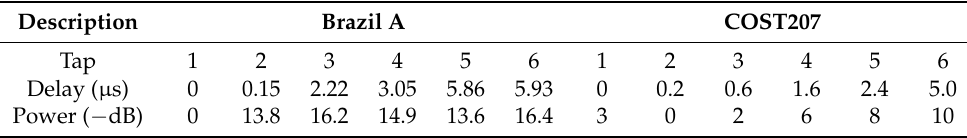
Table 2. Parameters of channel